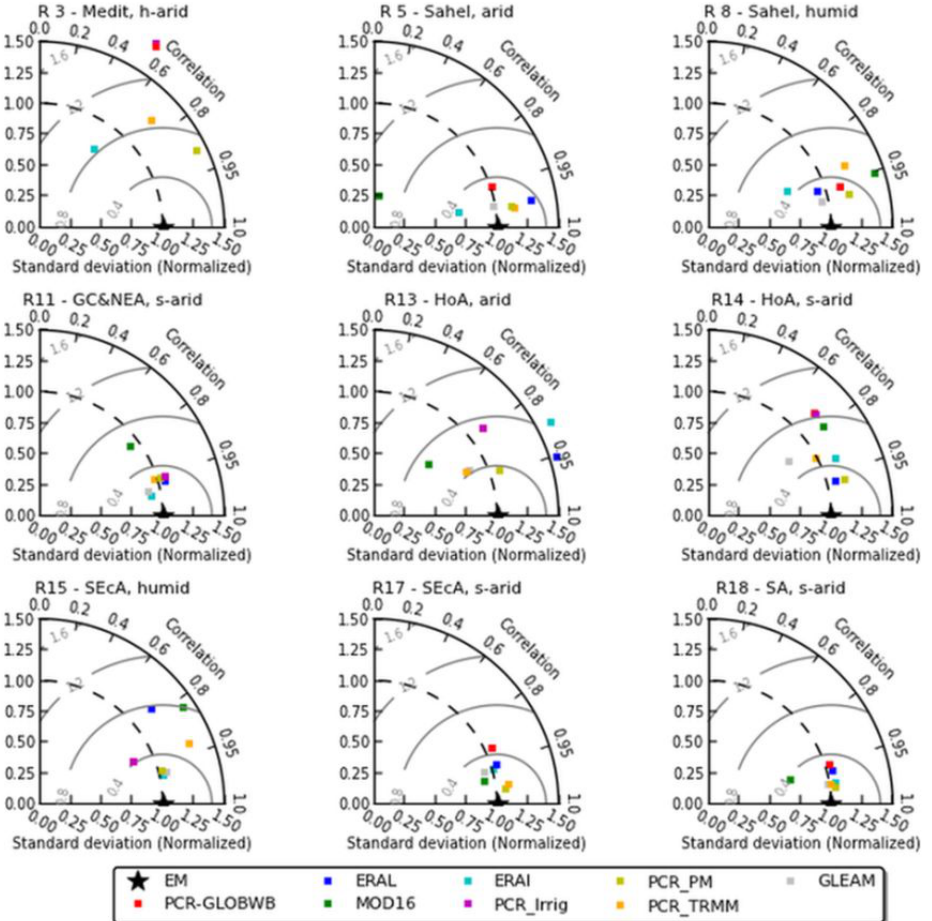
Fig. 8. Taylor diagrams summarizing the statistics between the monthly time series of the different products assuming the EM is the “refer-